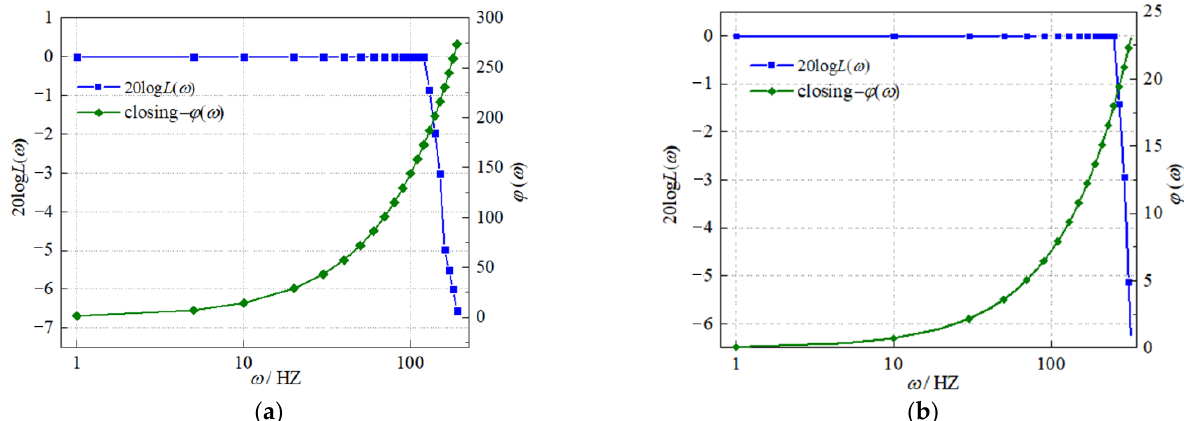
Figure 6. Frequency characteristics in the two driven strategies: ( a ) Amplitude-frequency curve in single voltage strategy; ( b ) Amplitude–frequency curve in PECA.